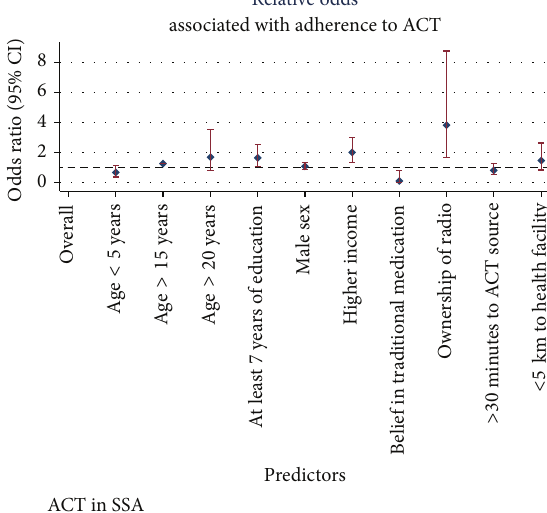
Figure 4: Sociodemographic predictors of ACT adherence.